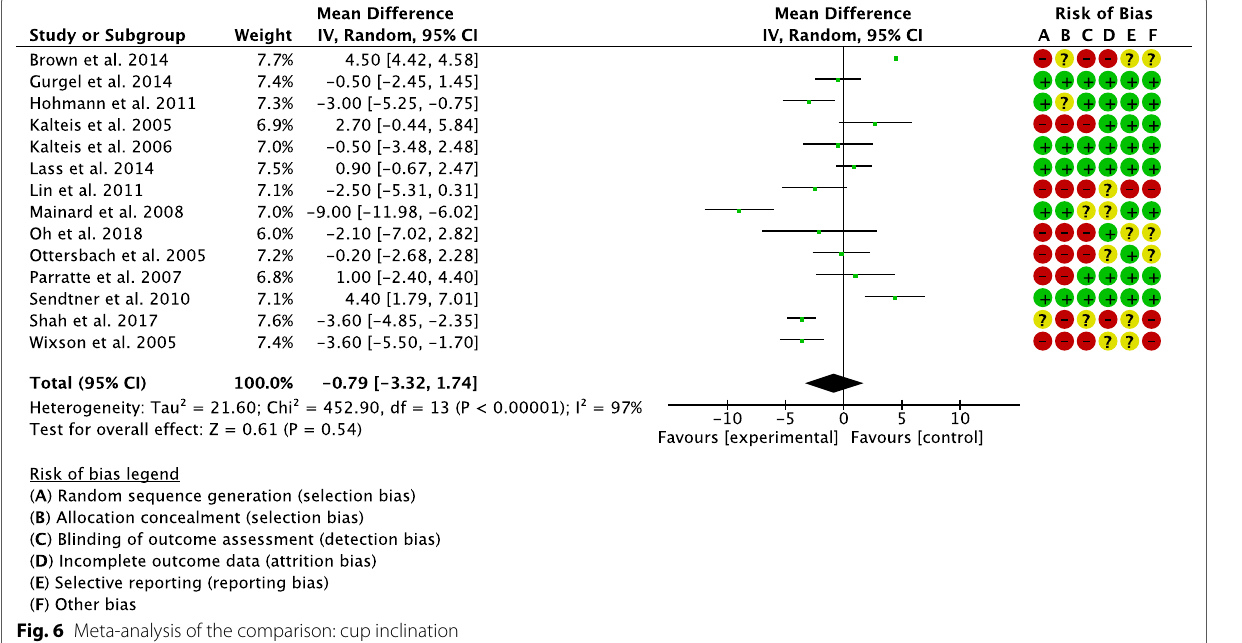
Fig. 6 Meta-analysis of the comparison: cup inclination